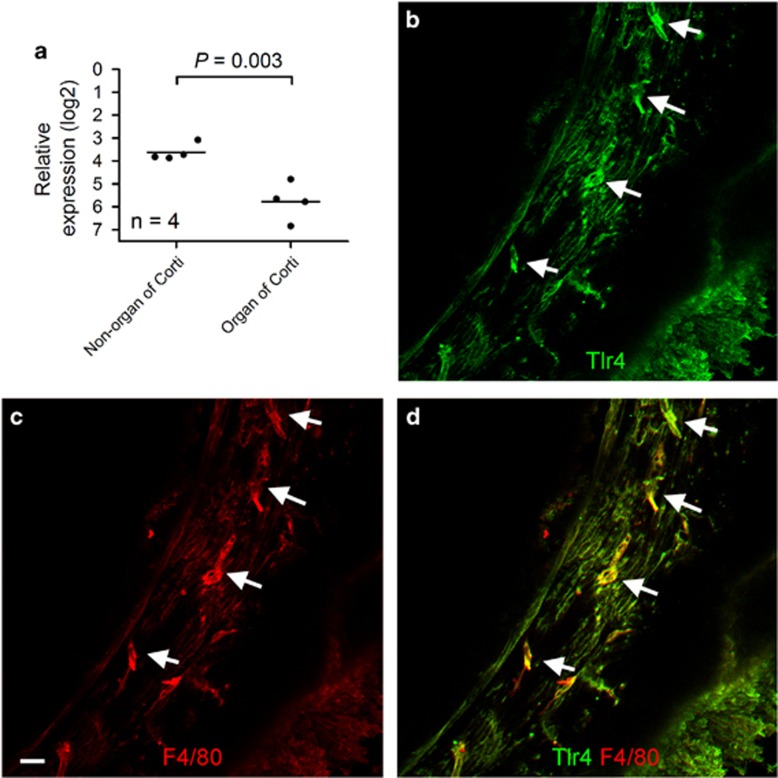
Tlr4 expression in non-organ of Corti tissues. (a) Constitutive expression of Tlr4 mRNA in the organ of Corti and non-organ of Corti tissues. The non-organ of Corti tissues contain the lateral wall and the basilar membrane, where immune cells reside. The dots represent individual values, and the horizontal lines represent the group mean. The expression levels are normalized using two reference genes (Rpl13a and Hsp90ab1). The average expression level of Tlr4 in the non-organ of Corti tissues was significantly higher than in the organ of Corti (Student's t test, t (6)=4.72, P=0.003). (b) A typical image showing Tlr4 immunoreactivity in cells beneath the basilar membrane. Arrows indicate the positive cells with strong Tlr4 immunoreactivity. (c) Double-labeling of F4/80, a macrophage marker protein, in the same tissue. Bar=20 μm. (d) Merged image of (b and c). Notice that the cells with strong Tlr4 immunoreactivity are also F4/80-positive